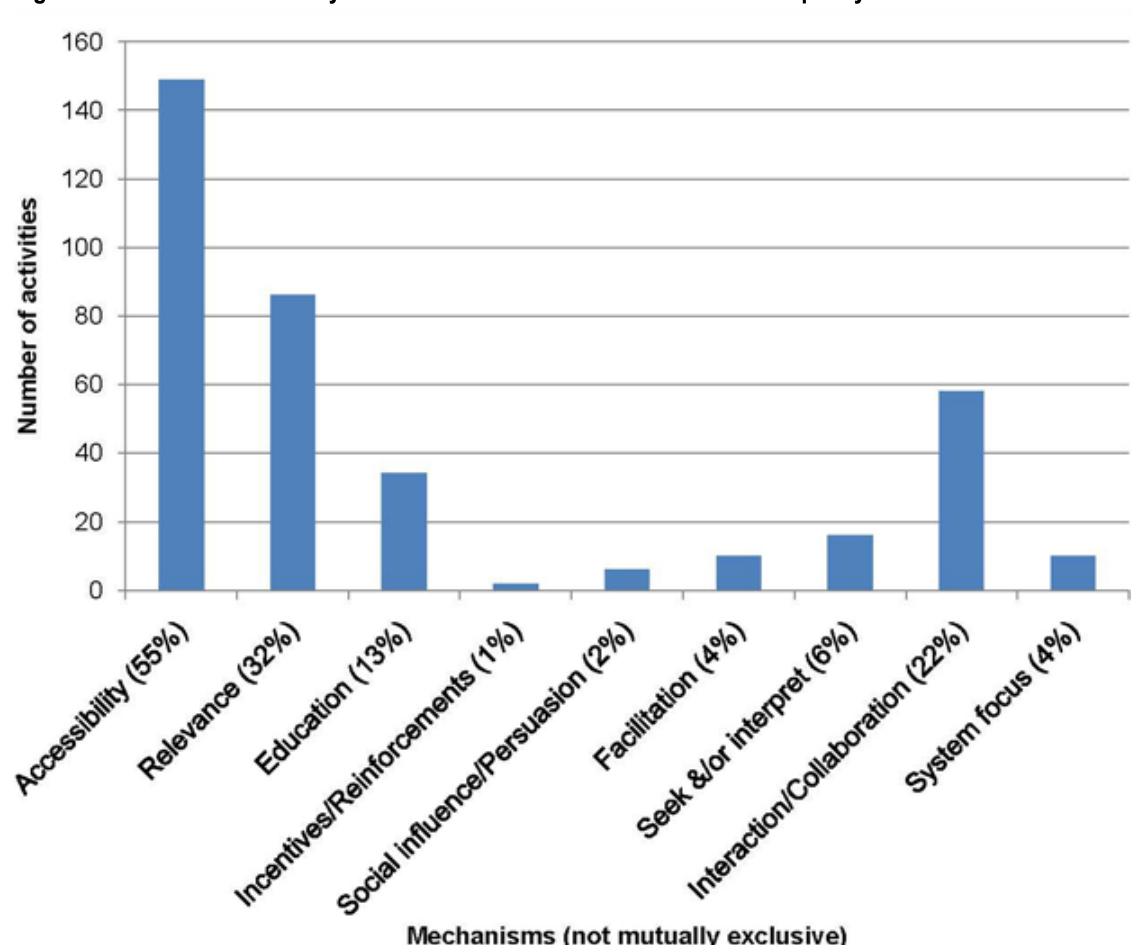
Figure 9: Mechanisms used by the activities to enable evidence informed